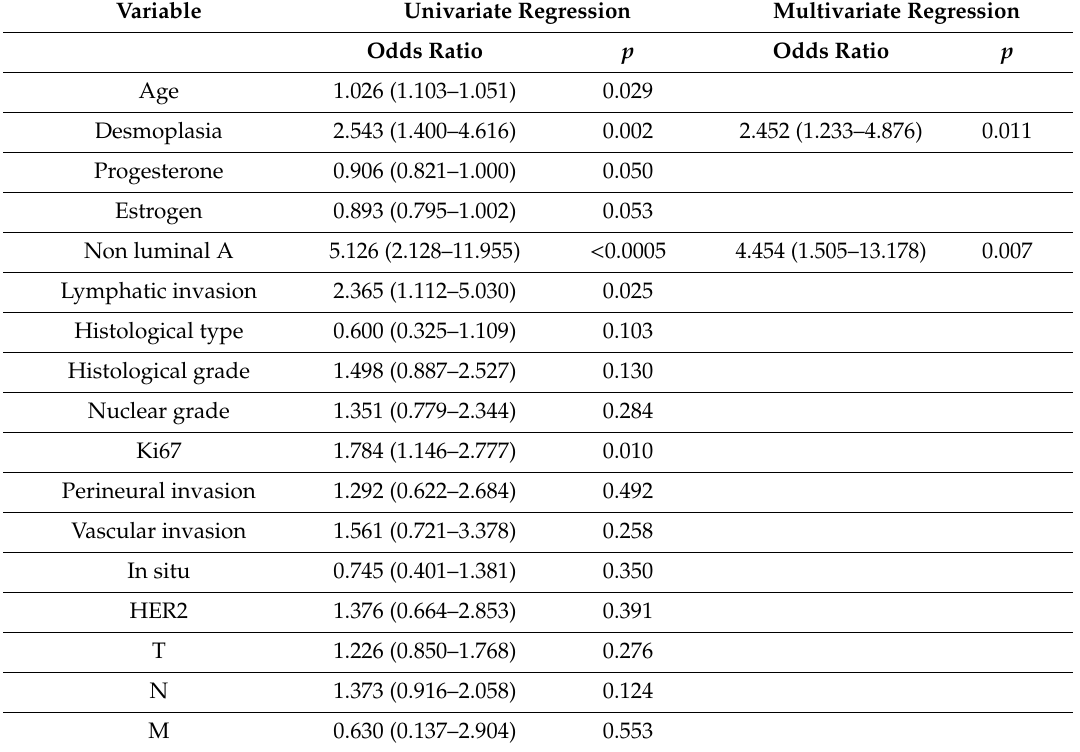
Table 4. Binary logistic